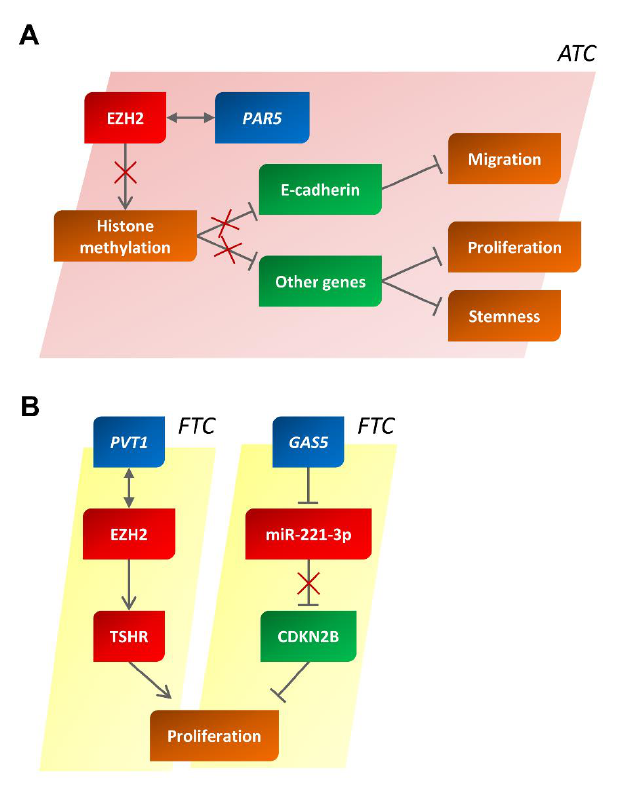
Figure 4. Deregulation of PAR5 and PVT1/GAS5 in anaplastic and follicular thyroid carcinomas. Schematic representation depicting the main pathways in which PAR5 ( A ) and PVT1/GAS5 ( B ) are thought to be involved. In red and in green, partners with an oncogenic or anti-oncogenic behavior are reported, respectively. ATC, anaplastic thyroid carcinoma; FTC, follicular thyroid carcinoma. Interestingly, a tumor suppressor role of PAR5 was also confirmed by studies on other cancer types. Indeed, PAR5 has also been found to be decreased in hepatocellular carcinoma and gliomas [118,119], where, interestingly, PAR5 has been reported to exert a tumor suppressor role through its interaction with EZH2. In fact, through a molecular interaction, PAR5 blocks the ability of EZH2 to alter the methylation state of histones [120], thus unblocking the expression of a series of important genes that regulate cell proliferation and the stem-cell phenotype. This mechanism of action also seems to work in ATC. In fact, PAR5 is not only able to interact with EZH2, blocking its function, but it is also able to regulate its protein stability [97], as already reported for other lncRNAs [121,122] (Figure 4A). This observation is also supported by the inverse correlation of EZH2 protein levels with those of PAR5 in ATC tissues [97] and by previous studies that reported EZH2 overexpression in ATC but not in PTC and FTC [87]. It is also worth noting that PAR5 is able to block the action of EZH2 on the E-cadherin promoter (re- ported to be repressed through H3K27 trimethylation exerted by EZH2 [123]) by reduc- ing its binding to chromatin, thus allowing its expression. The role played by PAR5 is, therefore, clear in the late stages of neoplastic transformation and, in particular, during EMT and loss of cell differentiation.